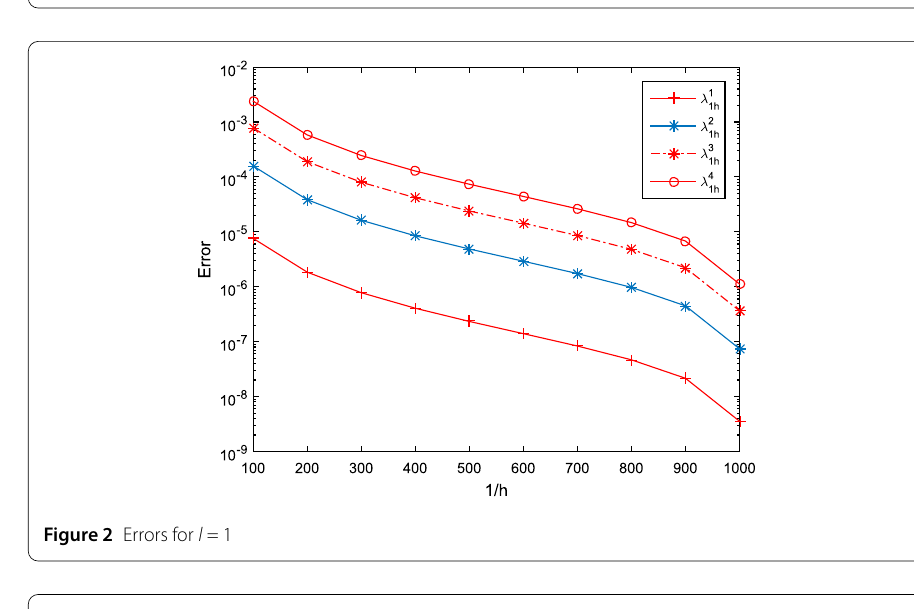
Figure 2 Errors for l = 1